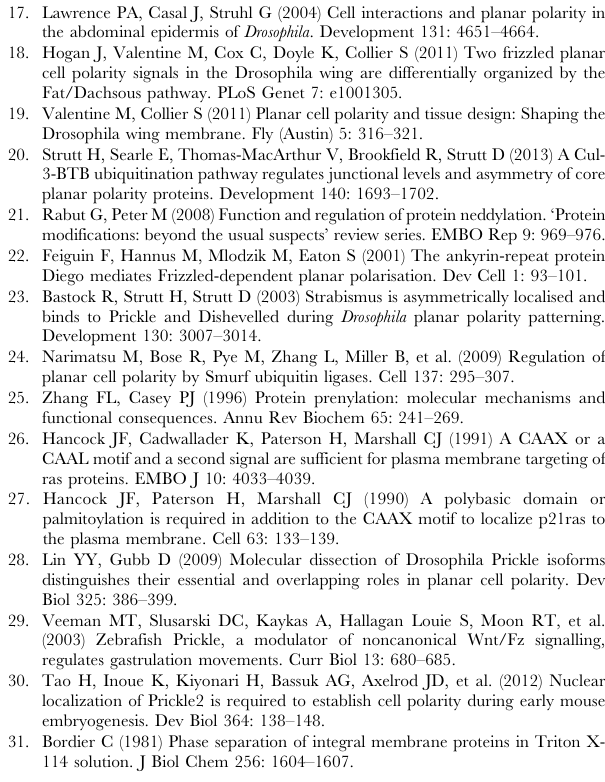
(arrows). A non-specific band on the HA blot is marked with an arrowhead. (TIF) Figure S3 Partial requirement for Sple farnesylation in the leg. (A–G) Adult legs from wild type (A), pk pk-sple13 (B), pk sple1 (C), pk pk- sple13 ; ActP - EGFP-sple/ + (D), pk pk-sple13 ; ActP - EGFP-sple D CaaX/ + (E), pk sple1 ; ActP - EGFP-sple/ + (F) and pk sple1 ; ActP - EGFP-sple D CaaX/ + (G) flies. Tarsal segments 1–5 are marked in panel A. Black arrowheads show joints, and grey arrowheads are partial ectopic joints. 50% of pk pk-sple13 ; ActP - EGFP-sple D CaaX/ + and pk sple1 ; ActP - EGFP-sple D CaaX/ + legs contain a partial ectopic joint in T4. (TIF) Figure S4 Effects of deleting the prenylation motif of Pk or Sple in the pupal wing. (A,B) 28 hr pupal wings expressing clones of ActP-EGFP-sple (A) and ActP-EGFP-sple D CaaX (B), stained for GFP (green) and Fmi (red). EGFP-Sple localises to distal cell edges, in a region of the wing where trichome polarity is reversed. Scale bar 20 m m. (C) pk pk-sple13 stbm 6 double mutant clone, marked by loss of ß-gal staining (blue), in a 28 hr pupal wing expressing ActP-EGFP- pk D CaaX . Staining is for GFP (green) and Ecad (red). (D) Western blot showing GFP levels relative to Actin levels, in 28 hr pupal wing extracts from ActP-EGFP-pk/ + ,and ActP-EGFP-pk D CaaX/ + flies. (TIF) Figure S5 In vitro analysis of Pk prenylation and binding to Stbm. (A) Phase separation of the HA-tagged C-terminus of Myc- Pk-PP-HA, after cleavage with PP. Cells were transfected with pAc5.1-Myc-Pk-PP-HA , with (right) or without (left) pMK33ß-Stbm- EYFP . Blots show HA staining of total lysate, aqueous fraction (Aq) or detergent fraction (Det). No prenylation of Pk is observed